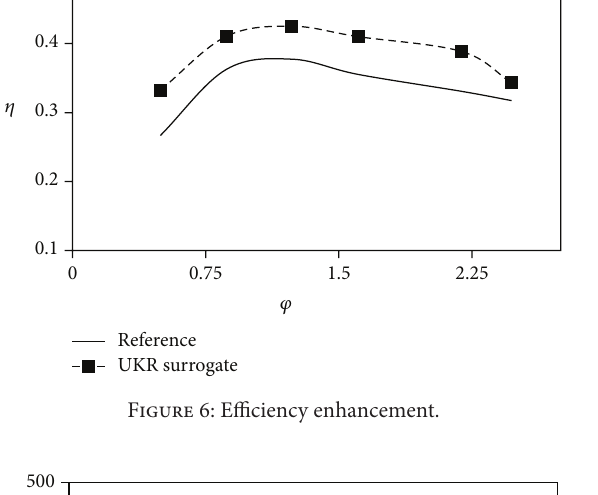
Figure 8: Effect of flow rate on pressure drop.